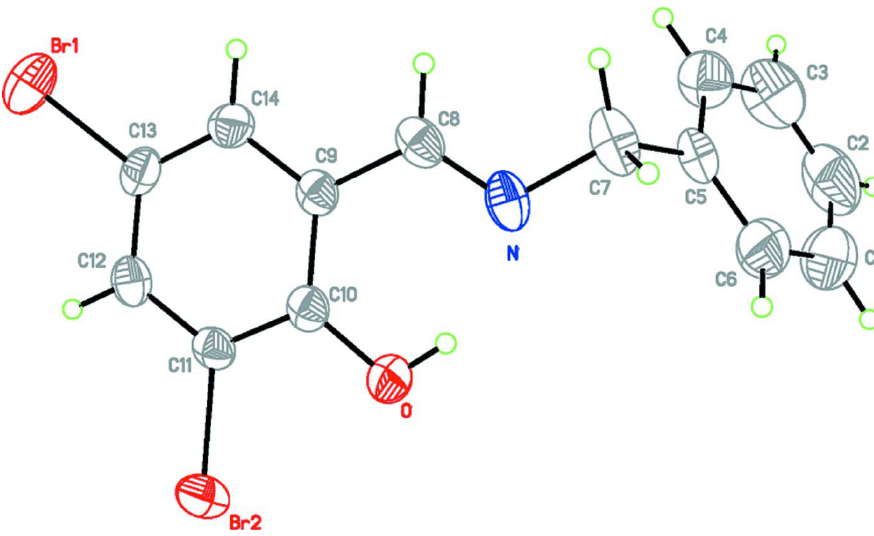
Figure 1 The structure of (I), showing displacement ellipsoids drawn at the 30% probability level.